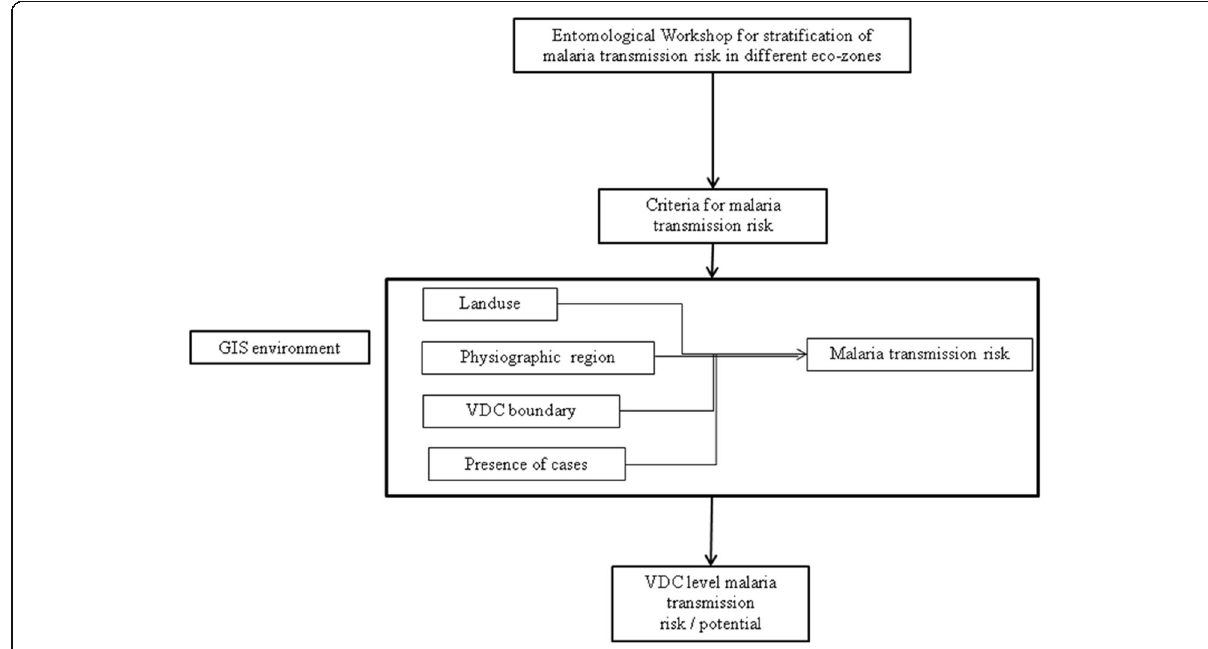
Fig. 3 Flowchart showing steps to derive transmission risk by ecological